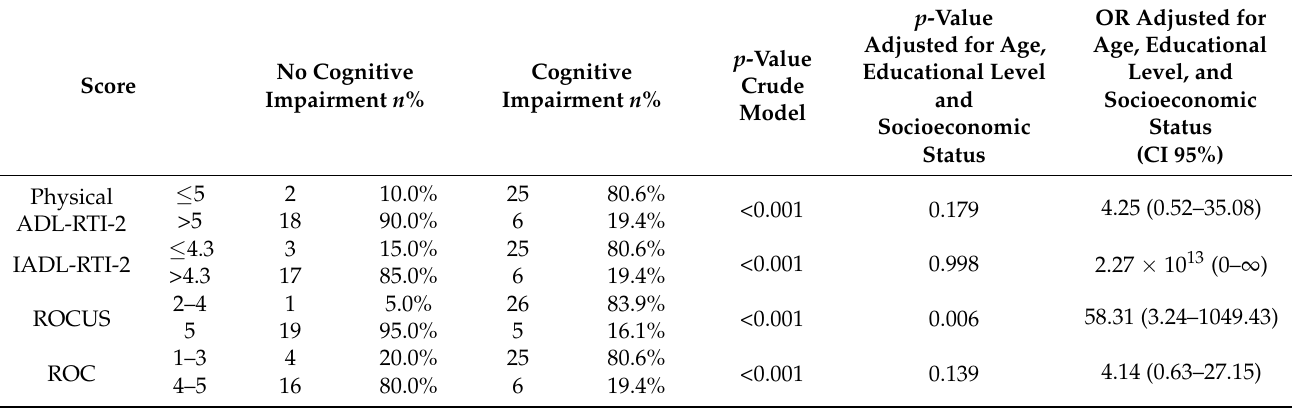
Table 5. Multivariate model with binary logistic regression for ADL and categorization